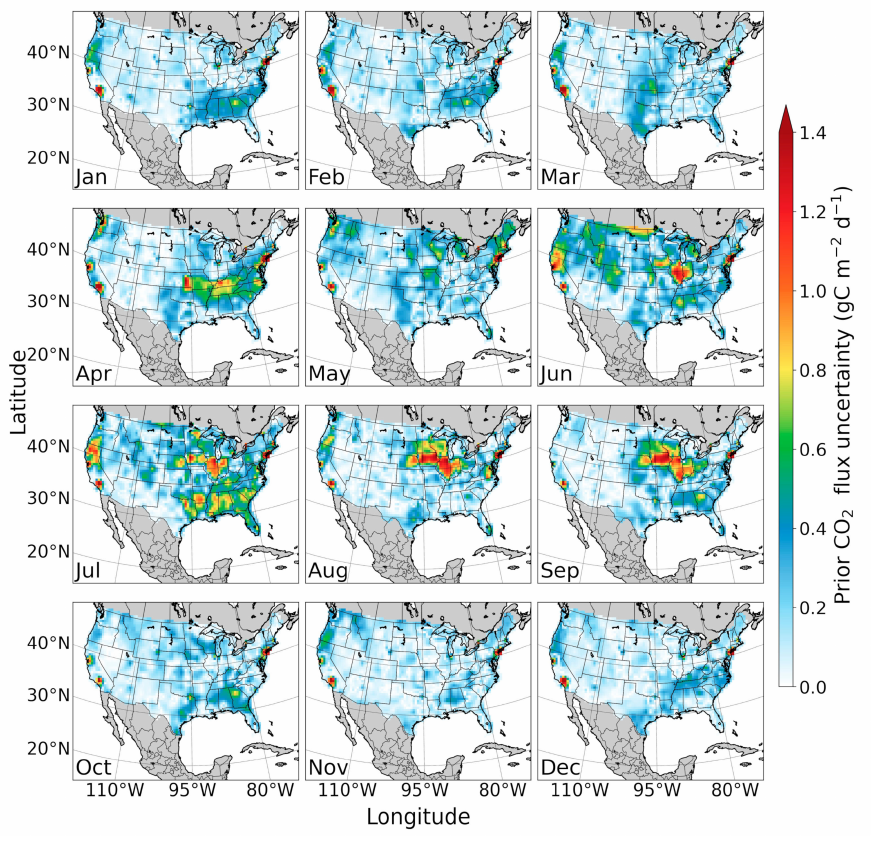
Figure 6. Spatial distribution of monthly mean uncertainty of the prior CO 2 flux over the contiguous United States in 2016 used in the DA_FLUX experiment.